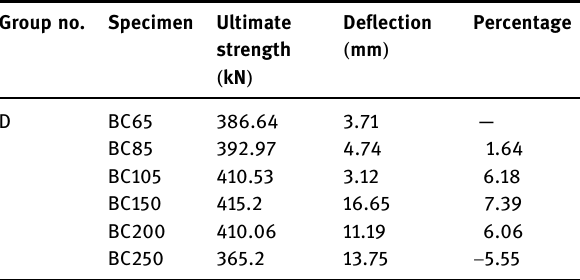
Table 5: Ultimate strength and de fl ection of midspan of Group D Group no. Specimen Ultimate